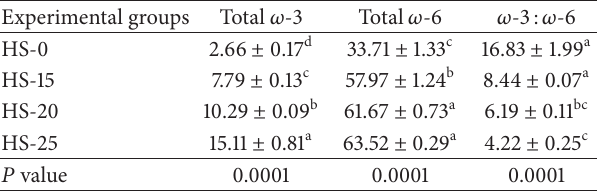
Table 5: Mean ± SE of total 𝜔 -3 (mg/g), total 𝜔 -6 (mg/g), and 𝜔 - 6 : 𝜔 -3 in eggs from hens consuming different levels of hemp seed ( 𝑛 = 3